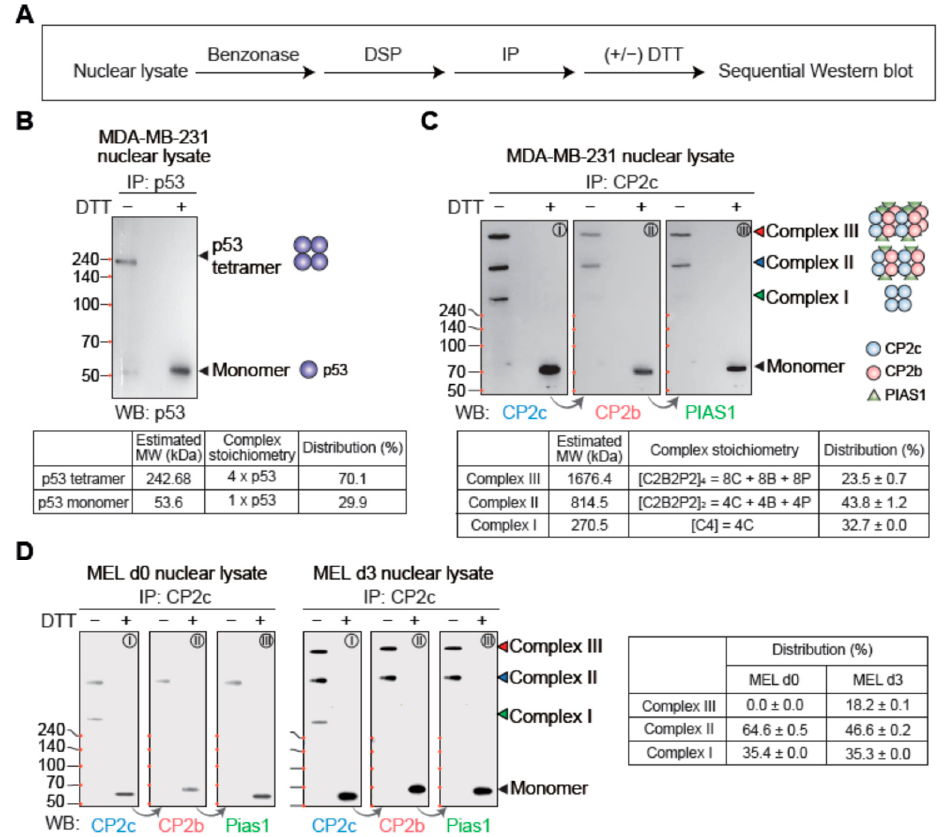
Figure 4. CP2c exists as complexes of either monomeric tCP2c or multimeric CBPs in the nucleus. ( A ) Experimental scheme to identify CP2c complex types and proportions of each complex in the nucleus by DSP crosslinking and sequential Western blot. ( B ) Immunoblots showing preferential distribution of p53 tetramer over monomer in the nucleus (top) and estimation of the protein complex sizes, and stoichiometry and relative ratios of each complex (bottom). Samples were subjected to 10% SDS-PAGE. The protein complex sizes were estimated by determining the relative migration distance [27] of the protein standards. ( C , D ) Identification of various nuclear forms of tCP2c or CBP complexes and estimation of the protein complex sizes, and stoichiometry and relative ratios of each complex. Nuclear extracts of MDAMB-231 ( C ) and MEL cells during in vitro differentiation (d0 and d3) ( D ) were used for sequential Western blotting. Samples were subjected to 10% SDS-PAGE.